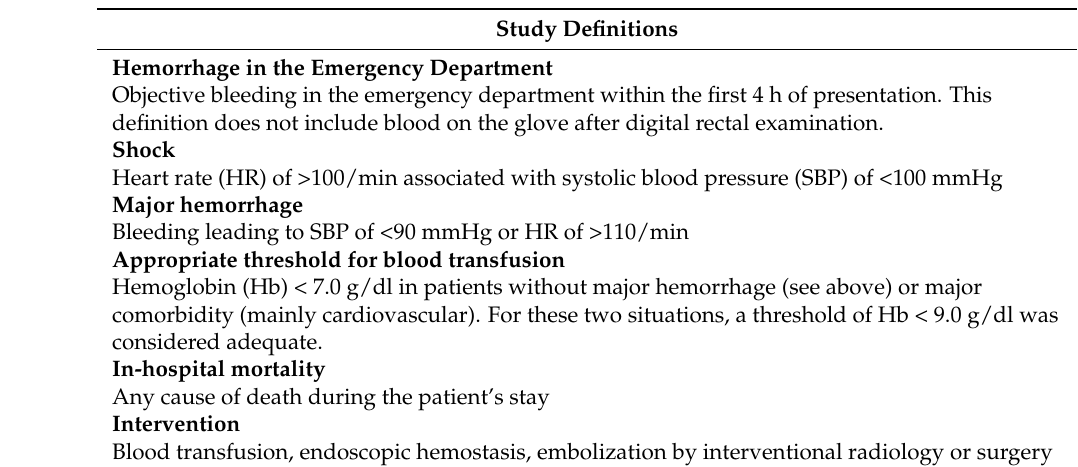
Table A2. Study definitions.